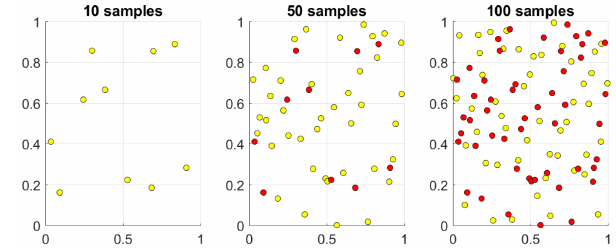
Figure 2. Exemplary presentation of samples based on Sobol se- quences with sample sizes 10, 50 and 1000. Red dots highlight points from the previous sample